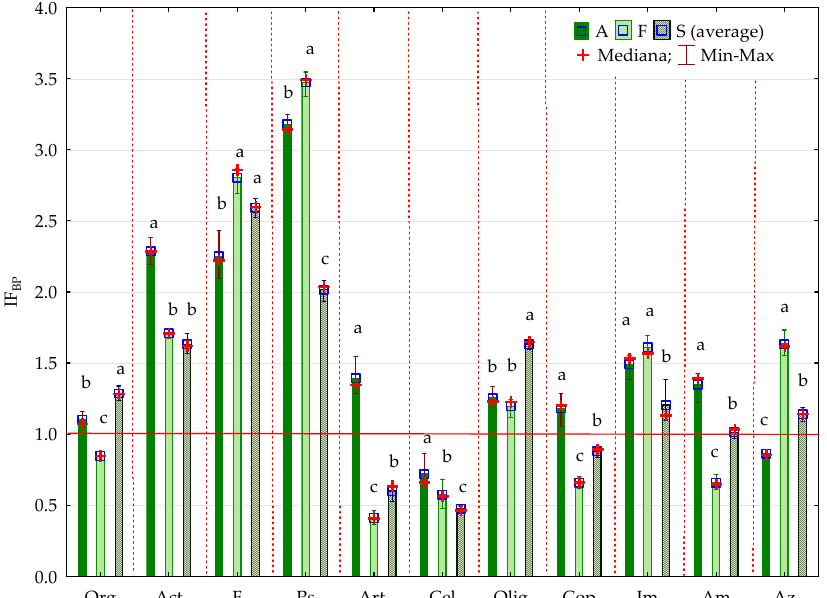
Figure 3. Coefficient of impact (IF BP ) of bisphenols for group of microorganisms in soil contaminated with BPA, BPF and BPS on the 30th day of research; Homogeneous groups denoted with letters (a–c) were calculated separately for each group of microorganisms (for abbreviations see Figure 1).